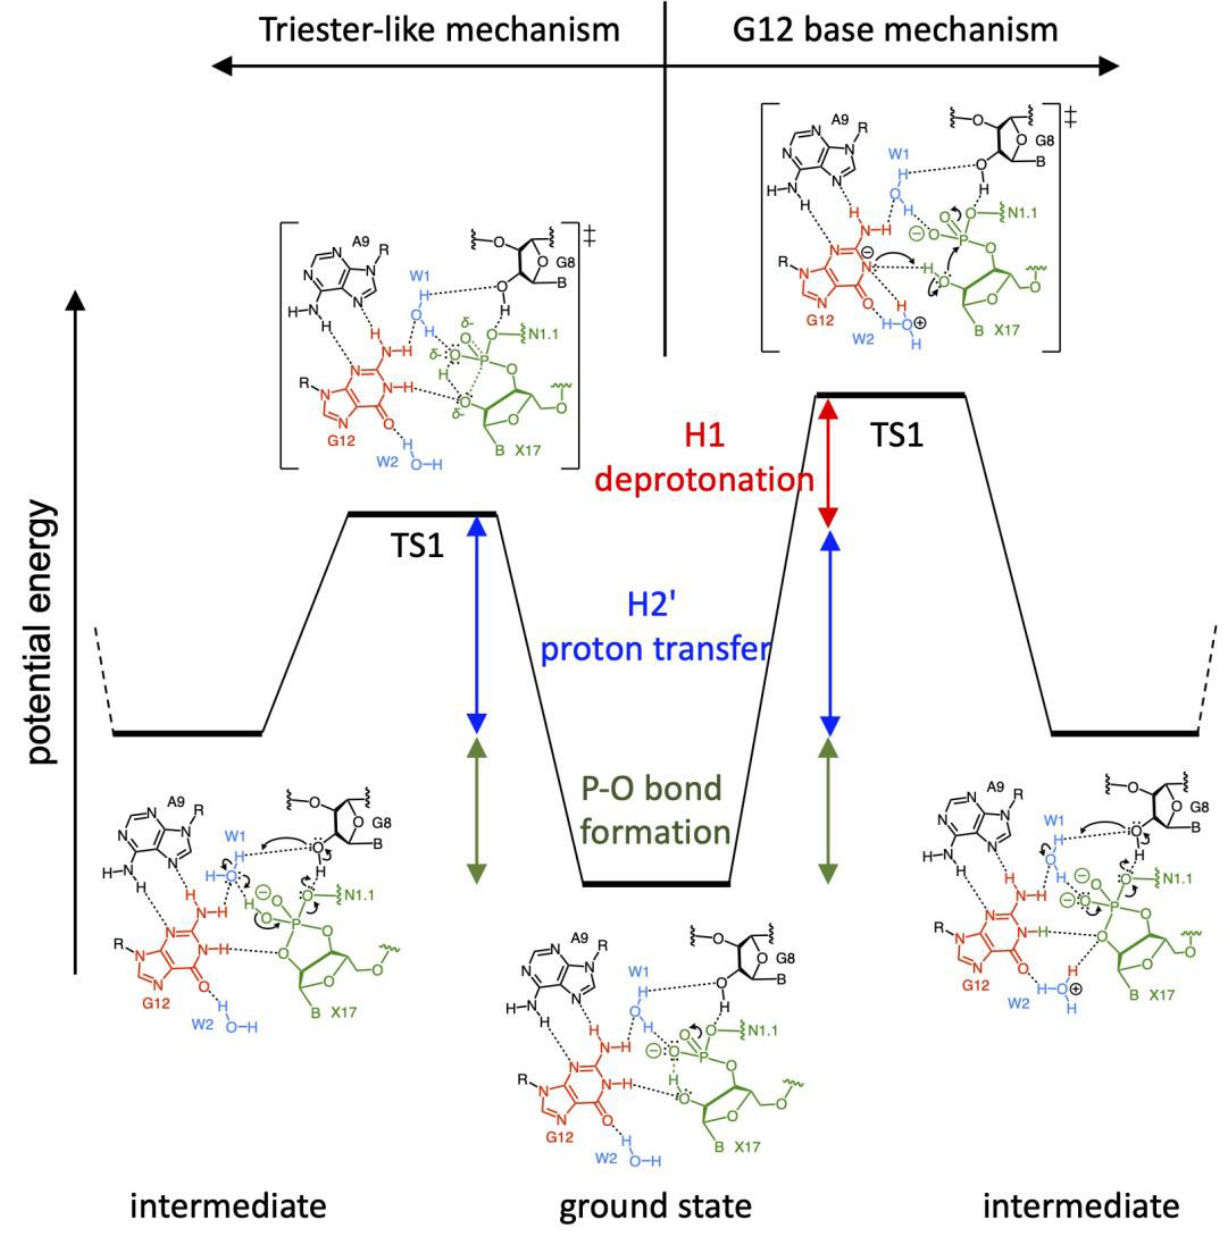
Figure 9. Potential energy profiles of the G12 base mechanism and triester-like mechanism. Energetic contributors for the first transition state are indicated with arrows.